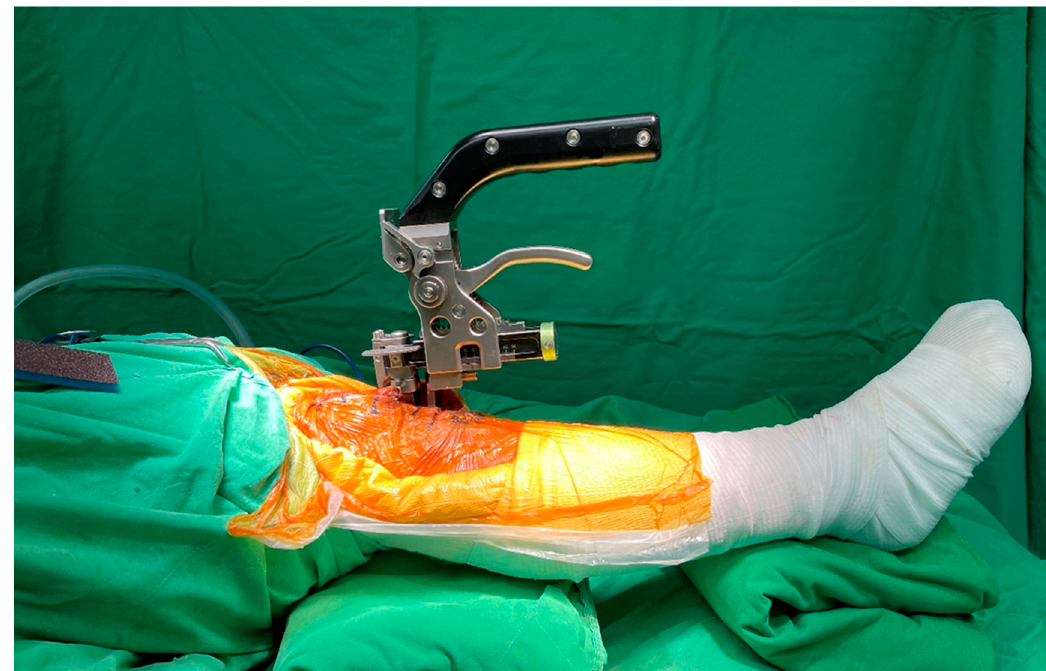
Figure 2. Measurement of the extension gap (E gap) using the tensioner. The lower limb was placed in full extension and the patella was placed in the anatomical position during measurement.